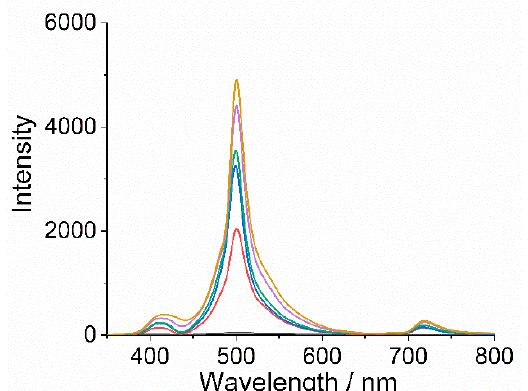
Figure 4. Resonance light scattering (RLS) spectra of the samples at the end of the aggregation process catalyzed by CoT 4 at different concentrations of this metal derivative. (Experimental conditions: [TPPS 4 ] = 3 μ M; [HCl] = 0.00158 M, [CoT 4 ] = 0.1 μ M (black), 0.3 μ M (red), 0.4 μ M (blue), 0.5 μ M (green), 1 μ M (violet), 1.5 μ M (yellow), T = 298 K).